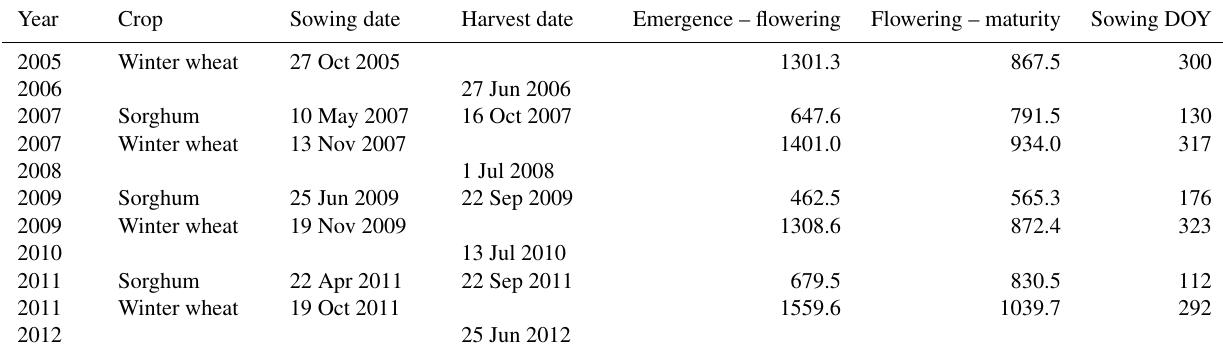
Table 4. Thermal times in degree days used in this study for the Avignon site; these are based on the observed sowing and harvest dates from Garrigues et al. (2015a).